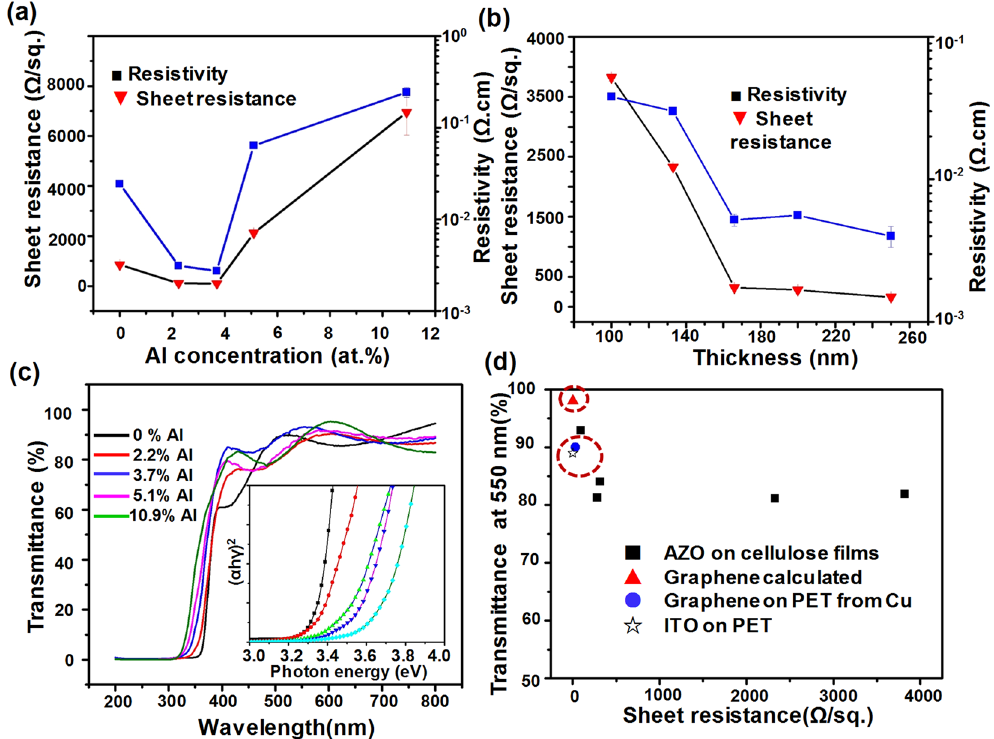
Figure 2. The electrical and optical properties of AZO-CNF papers. ( a ) The sheet resistance and resistivity measured as a function of Al concentration. ( b ) The sheet resistance and resistivity measured as a functional of AZO film thickness. All the AZO films had an Al concentration of 3.7 at.%. ( c ) Transmittance of the AZO-CNF papers with different Al concentrations. Inset is the corresponding Tauc plots revealing the bandgap change. ( d ) Transmittance (at 550 nm) and sheet resistance of AZO-CNF in comparison with other typical flexible transparent electrode